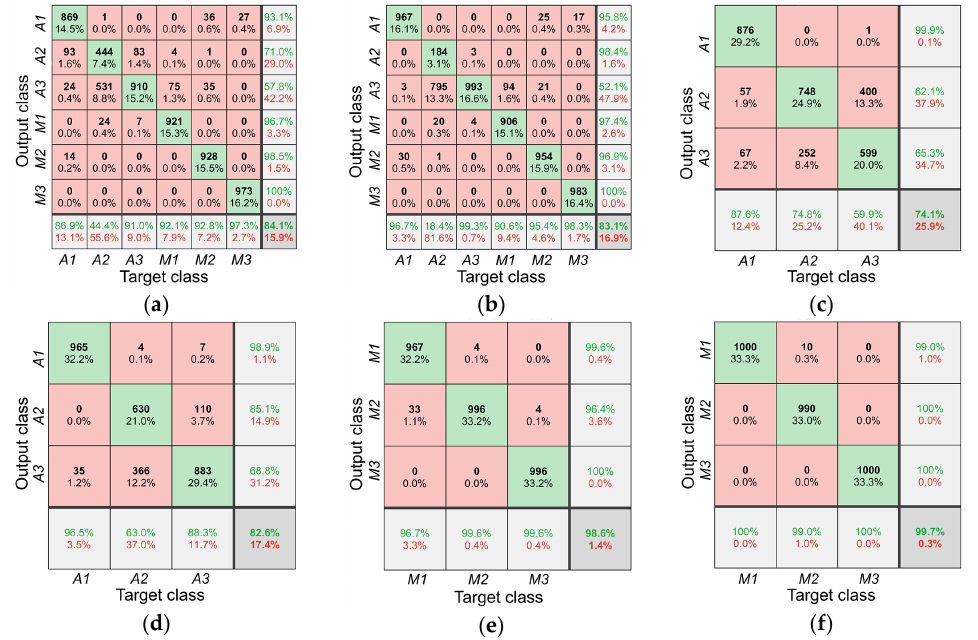
Figure 4. Confusion matrix for origin discrimination of all honey ( a ) LDA model and ( b ) SVM model, acacia honey ( c ) LDA model and ( d ) SVM model, multi-floral honey ( e ) LDA model and ( f ) SVM model. The diagonal cells correspond to observations that are correctly classified. The off-diagonal cells correspond to incorrectly classified observations. Both the number of observations and the percentage of the total number of observations are shown in each cell. The column on the far right of the plot shows the percentages of all the examples predicted to belong to each class that are correctly and incorrectly classified. These metrics are often called the precision and false discovery rate, respectively. The row at the bottom of the plot shows the percentages of all the examples belonging to each class that are correctly and incorrectly classified. These metrics are often called the recall and false negative rate, respectively. The cell in the bottom right of the plot shows the overall accuracy.